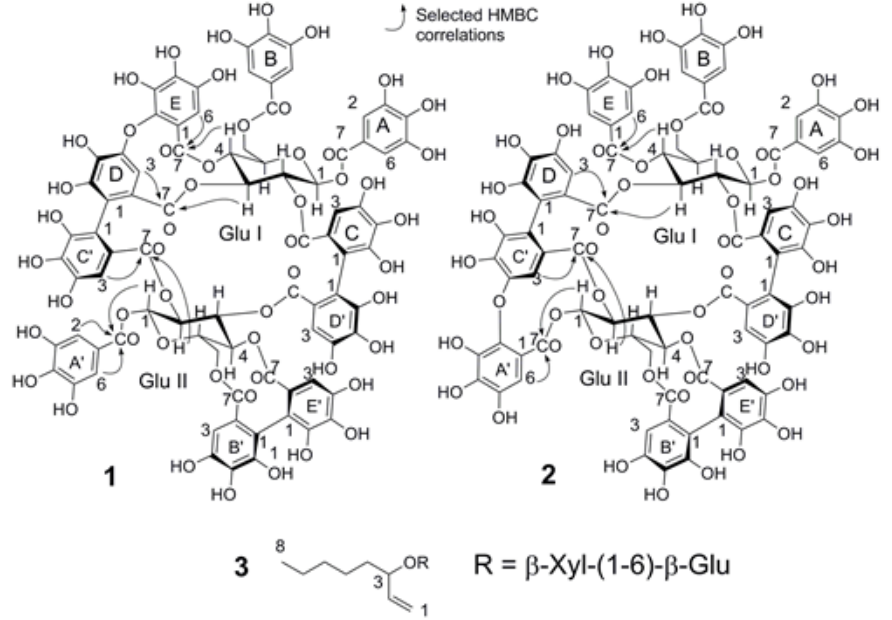
Figure 1. In Wikipedia, each entity has a canonical page and this is the canonical page for the entity Figure 4. New compounds isolated from M. hernandoi leaves. “ Michael Jordan ”. The description for the entity “ Michael Jordan ” consists of the words in the blue box. There are many hyperlinks in the page and the words around the hyperlink form the entity context for the corresponding entity. For example, the context for the entity “ North Carolina Tar Heels men’s Table 3. Connectivity between aromatic and glucose protons through the ester carbonyl carbon basketball ” consists of the words in the orange box. (three-bond coupling) for merianin A ( 1 ) and merianin B ( 2 ). 1 a 2 b Aromatic-H -COO- Glucose-H Aromatic- H